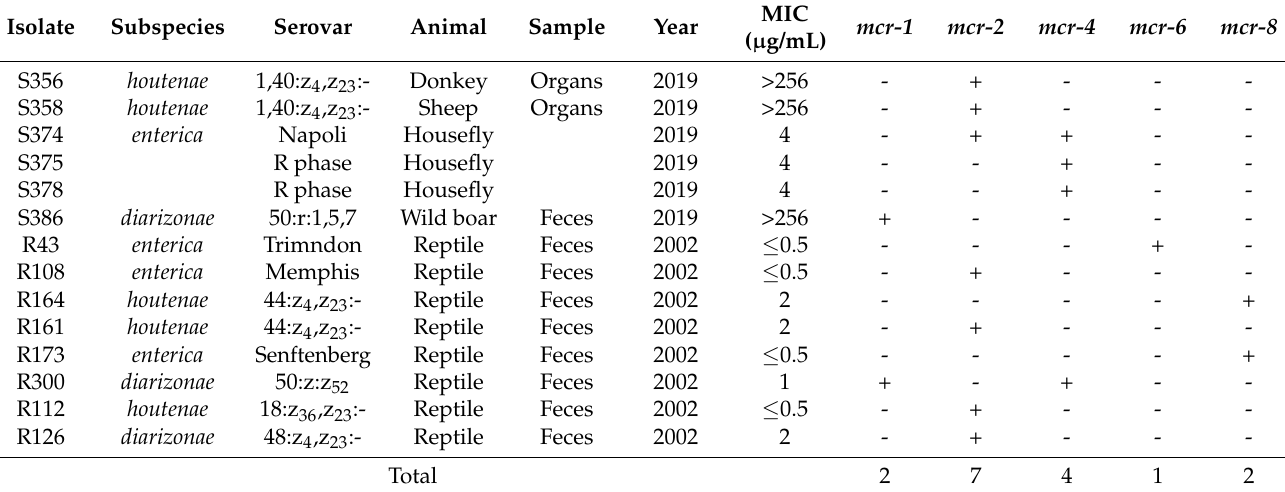
Table 6. Detailed information about the mcr -positive Salmonella